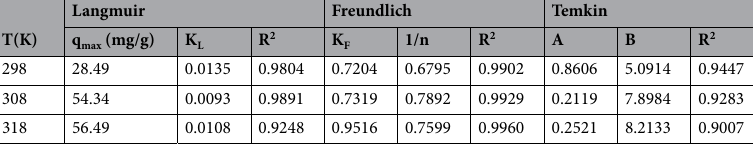
Table 3. Parameters of isotherm